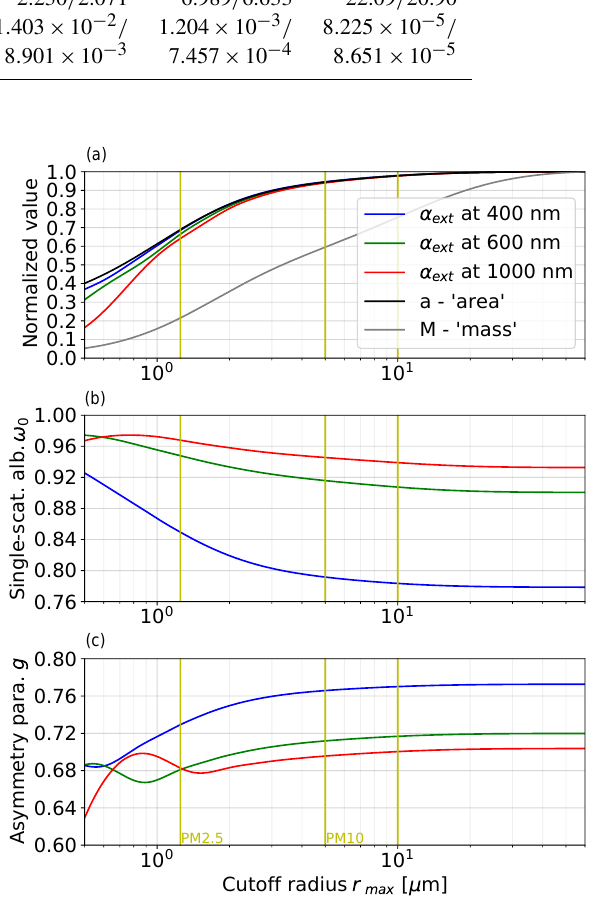
Figure 7. Optical and microphysical properties of the OPAC desert aerosol type as a function of cutoff radius r max . Panel (a) shows the normalized extinction coefficient α ext at three wavelengths, the normalized cross section density a , and the normalized mass con- centration M . Normalization to values calculated for r max = 60µm. The single-scattering albedo ω 0 at the same wavelengths is plotted in (b) , and the asymmetry parameter g in (c)